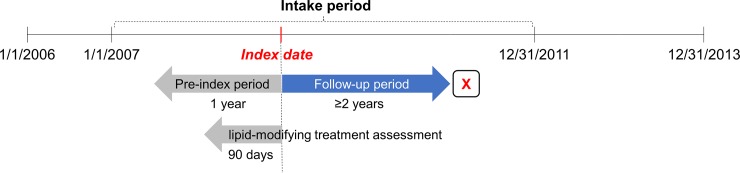
Study design scheme.The index date was defined as the first date of health examination with low-density lipoprotein cholesterol measurement.